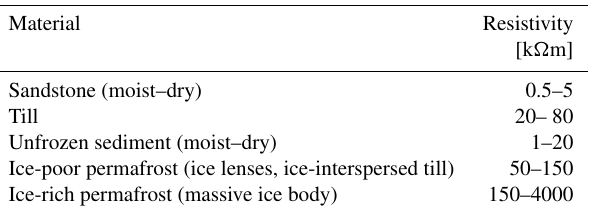
Table 3. Resistivity values for different materials derived by field measurement. The used terms of the interpreted material followed Hauck and Kneisel (2008) and Mewes et al.